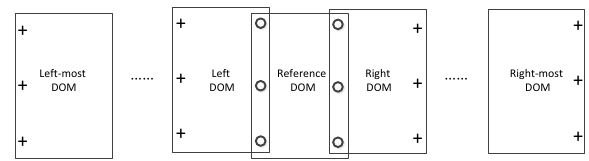
Figure 2. Illustration of control points (circles) and auxiliary control points (crosses) in TPS-based DOM